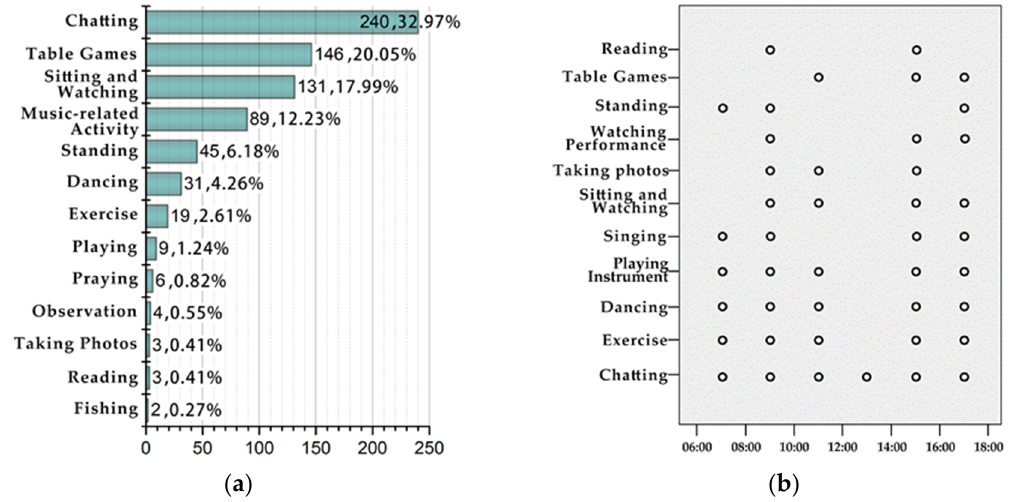
Figure 5. ( a ) Frequency of activities; ( b ) Duration of activities.